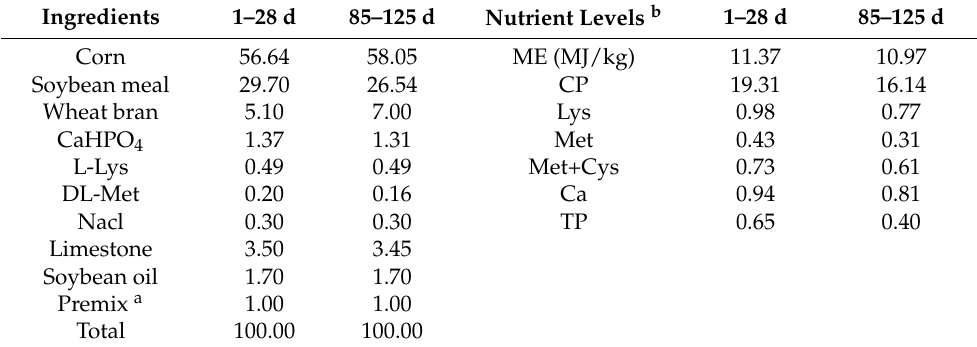
Table 1. Composition and nutrient levels of the basal diet (dry;